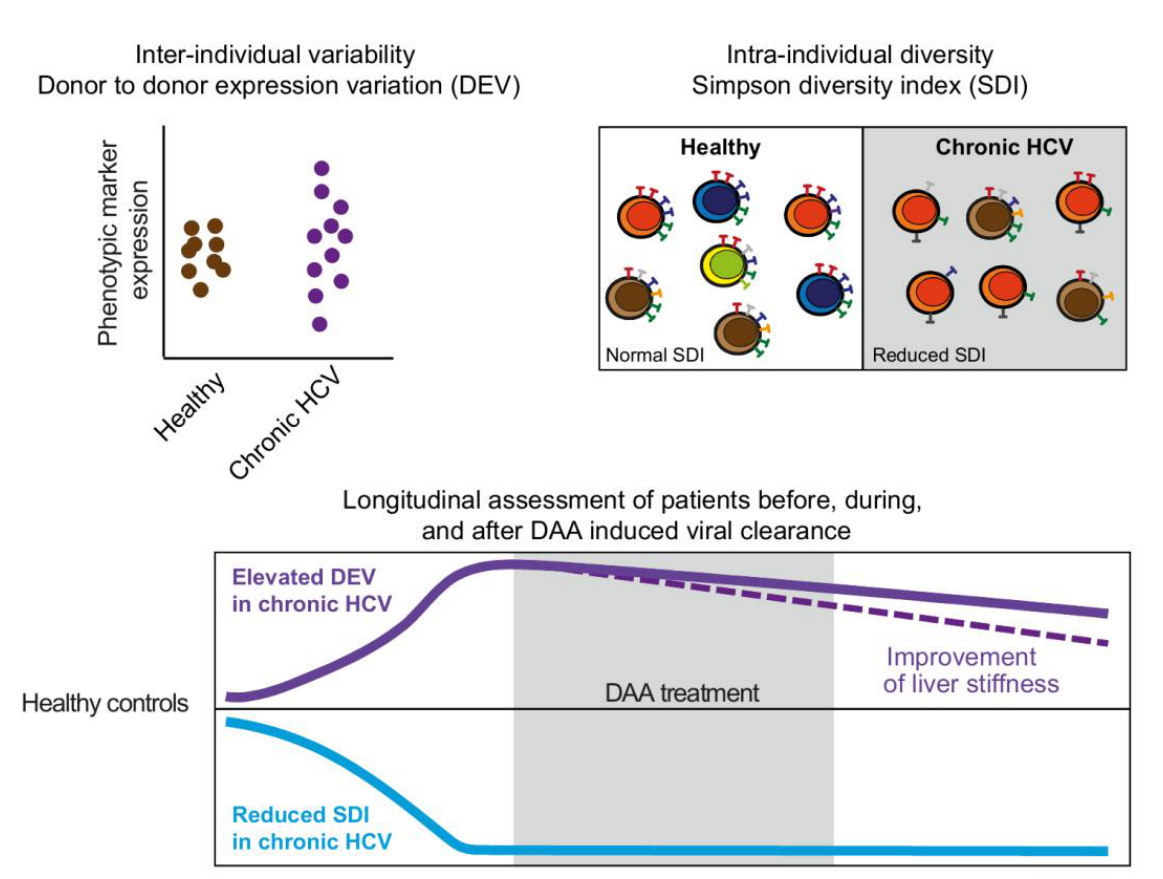
FIGURE 1: Imprint on NK cell diversity by chronic HCV infection. Schematic illustration on how chronic HCV infection affects NK cell inter- individual variability evaluated determining donor-to-donor expression variation (DEV) (top left panel). Assessment of intra-individual diversity within the NK cell population using the Simpson diversity index (SDI) in healthy controls and patients with chronic HCV (top right panel). Longitudinal characterization of DEV and SDI in chronic HCV infection, before, during, and after viral clearance using direct-acting antivirals (DAA) (lower